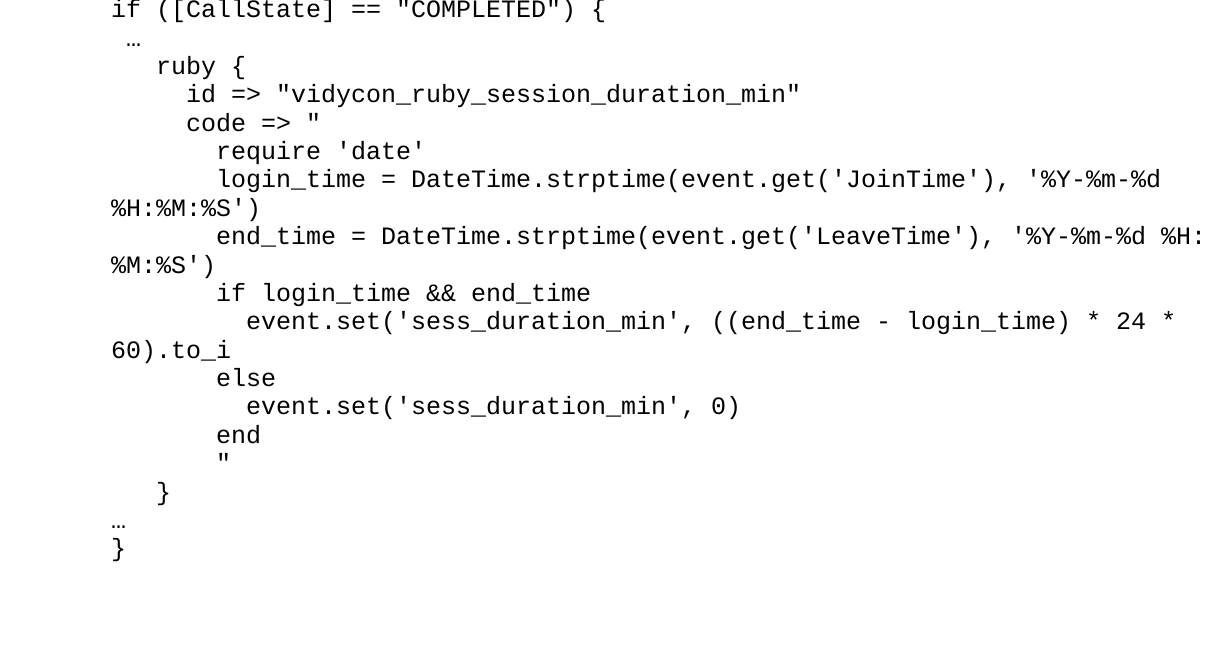
Table 2. Sample of logstash